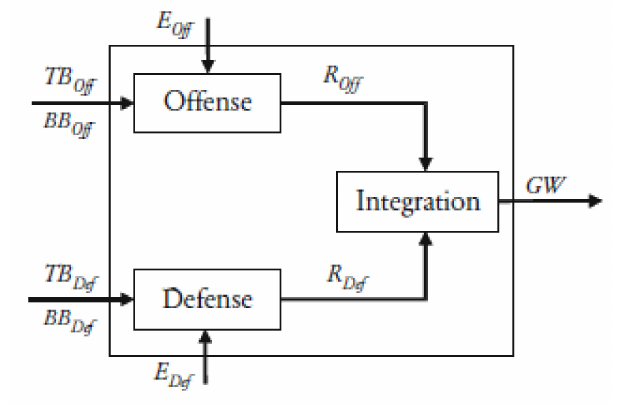
Figure 1. Network DEA model for MLB team operations and management e ffi ciency